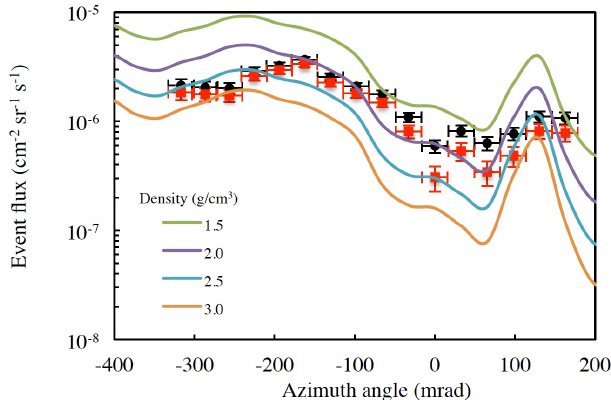
Figure 16. Azimuth distribution of event flux measured at the Shinmoe-dake volcano. The data collected at the elevation angle of 130mrad are plotted along with the theoretical flux calculated for different density values (1.5, 2.0, 2.5, and 3.0gcm − 3 ). The data before (black squares) and after (red squares) the background event removal are